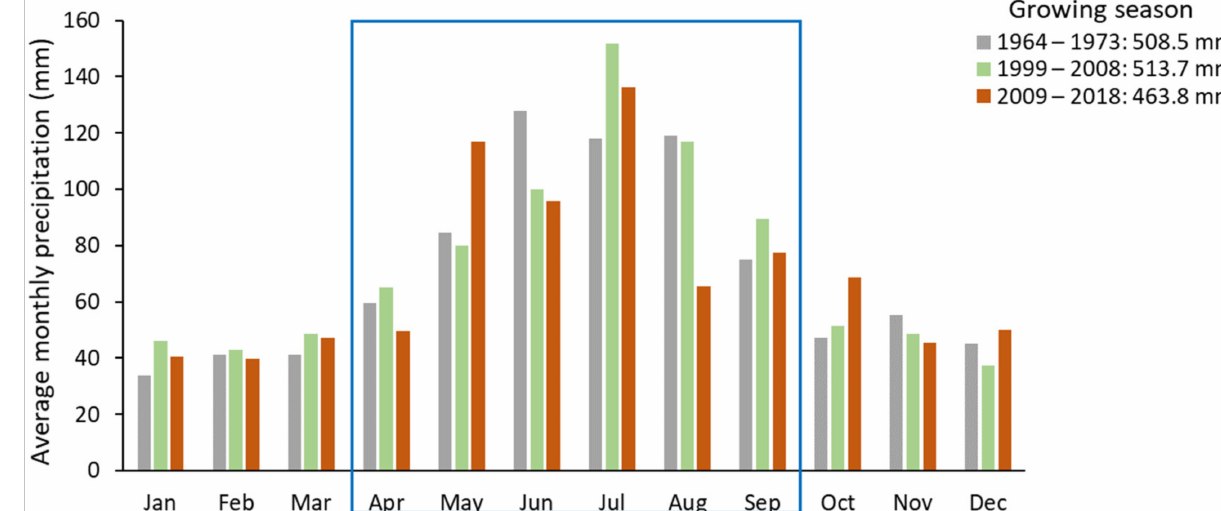
Figure 6. Average monthly precipitation in the periods 1966–1975, 1999–2008 and 2009–2018 based on climate data from the Lesko weather station (420 m a.s.l.). The blue frame encloses months falling within the growing